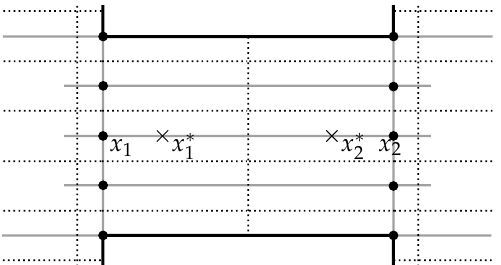
’s indicate the actual ×